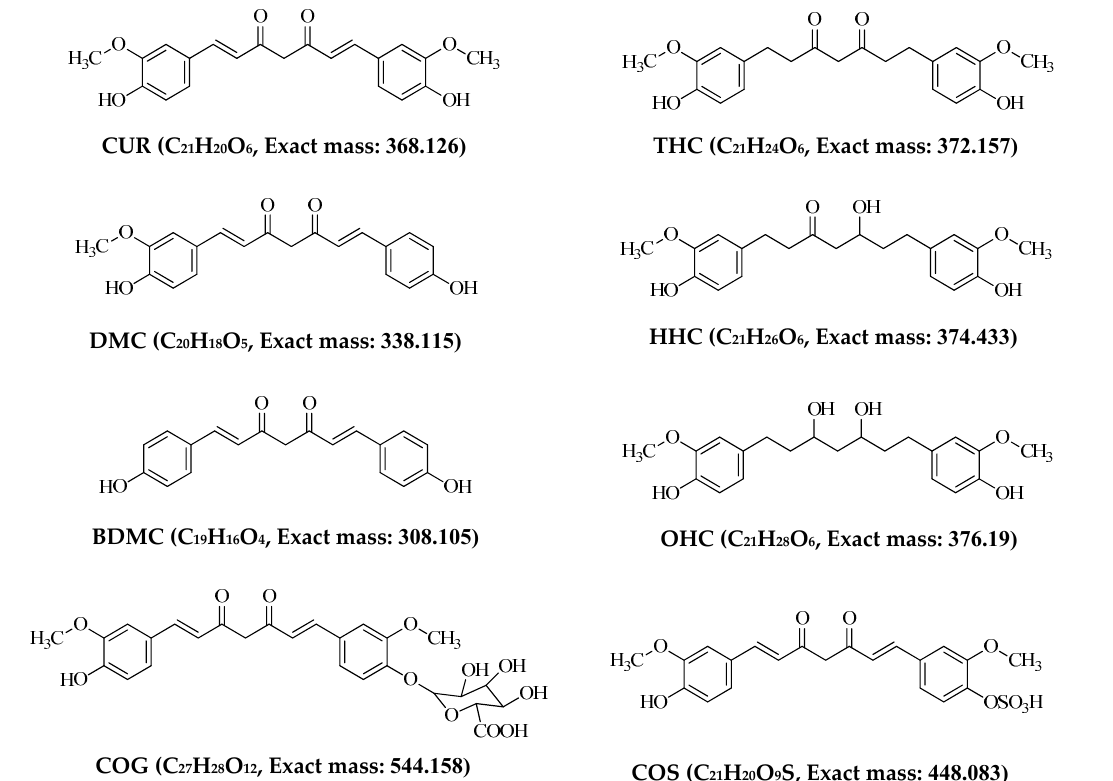
Figure 1. Chemical structures and theoretical masses of curcuminoids and curcumin metabolites.